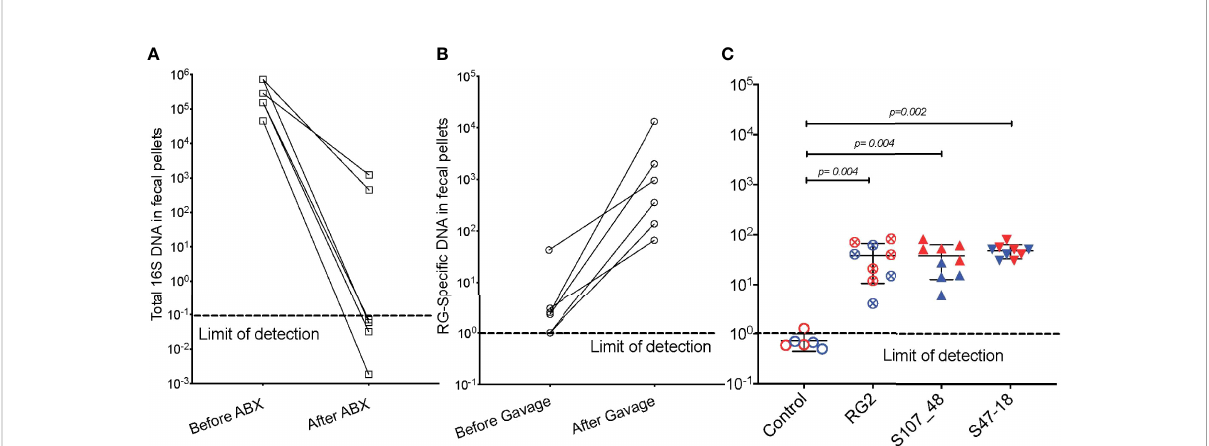
FIGURE 3 Broad-spectrum oral antibiotic-conditioned mice raised under speci fi c pathogen-free (SPF) conditions were colonized with diverse RG strains isolated from healthy and Lupus-affected human donors. The colonizing RG strains were then passed to their litters. (A) The fecal pellets of SPF- raised C57BL/6 breeding pairs were collected before initiating oral regimen of broad-spectrum antibiotics and repeated four weeks later, with total 16S rRNA genomic levels measured by qPCR analysis of extracts of fecal pellets. (B) Fecal pellets from these same mice were evaluated for levels of RG-speci fi c genomic DNA, before and after gavage with freshly cultured RG1, RG2 and S107-48 RG strains. (C) After mating of pairs based on same RG strain, abundance of RG genomic DNA in fecal pellets of 5wk-old litters was measured in each of the control (sham colonized, 3M 3F), RG2 (4M 5F), S107-48 (4M 4F) and S47-18 (4M and 5F) strain monocolonized SPF littermates, by RG-species speci fi c 16S rDNA genomic DNA by qPCR analysis. (Red) indicates female and (Blue) male mice are separately shown. Comparisons by unpaired t test, p values shown. Control group was gavaged with sterile